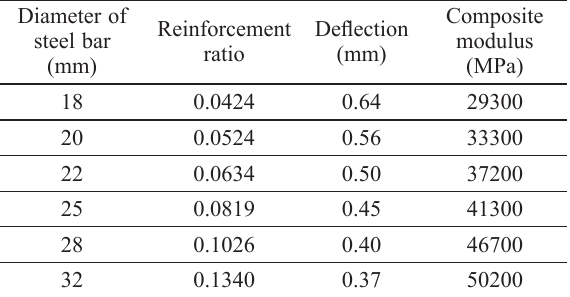
Table 3. Deflection and composite elastic modulus with concrete strength grade C25 under different reinforcement ratio Diameter of steel bar